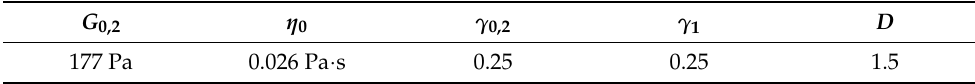
Figure 9. Viscosity variation with temperature above wax appearance temperature (WAT) (exper- imental and ftting curves) and extrapolation of viscosity by Arrhenius equation, with parameters A = 5.6 × 10 − 8 and E a = − 33.4 kJ. Table 3. Values of directly obtained parameters of the